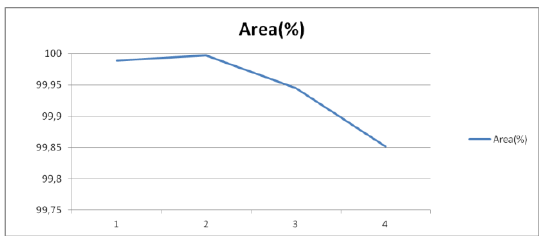
Figure 7 : The percentages of the area during the four phases of the simulation.